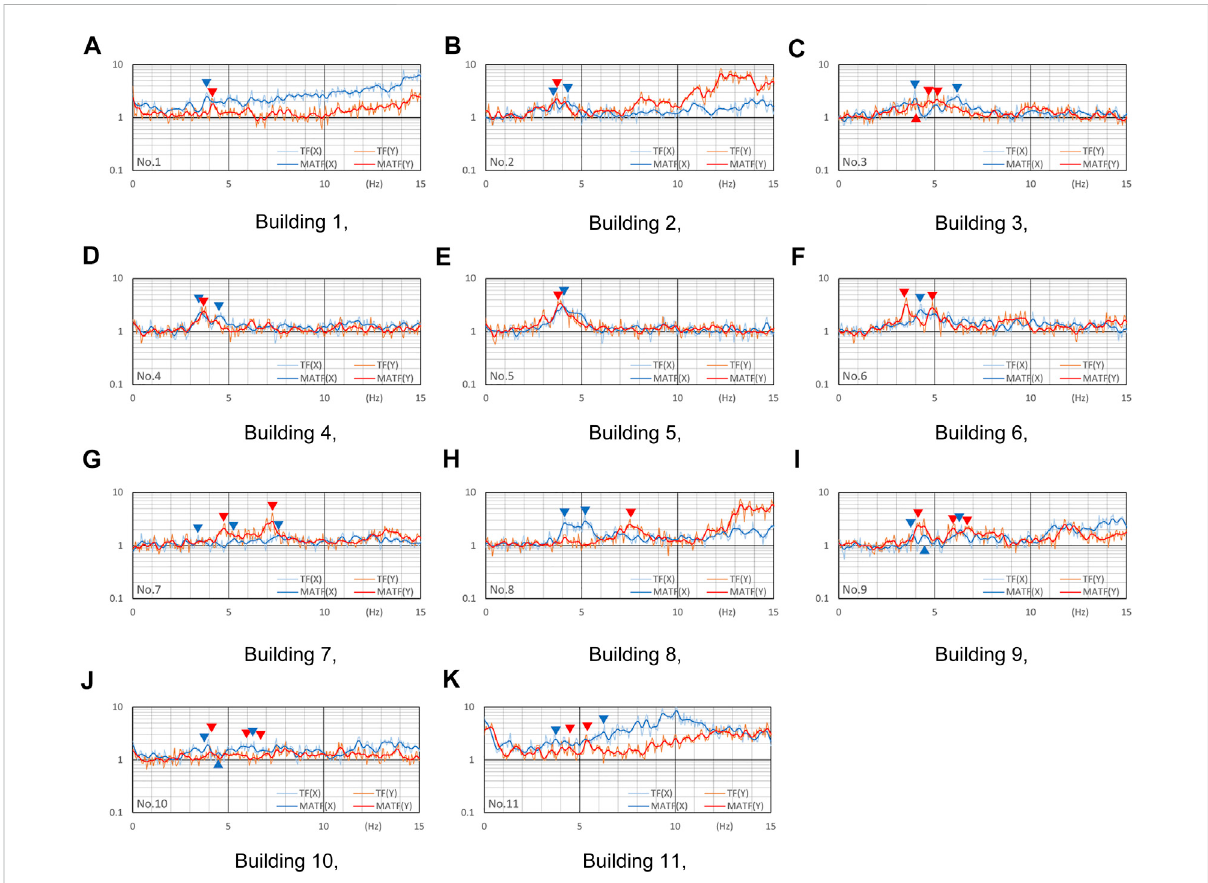
Frontiers in Built